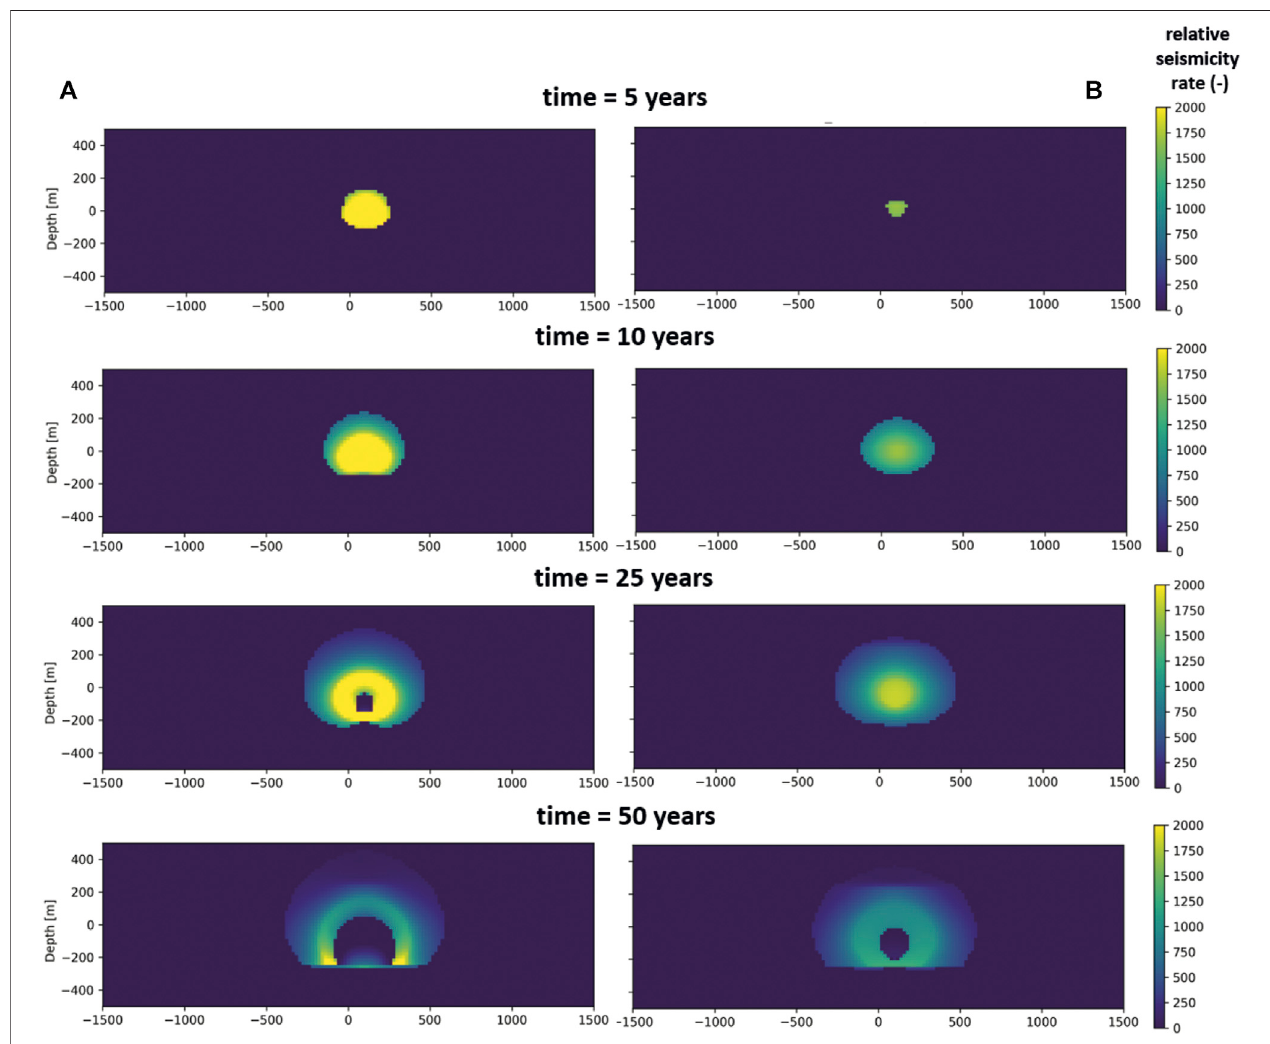
FIGURE8| Comparisonofrelativeseismicityrates( R )atthefaultplaneinalowstressenvironment.Locationofprojectedinjectionwellaty (cid:2) 0.Left (A) 2 mfracture spacing, right (B) 200 m fracture spacing. Mid-height reservoir at 0 m, units in depth (m) along dip.